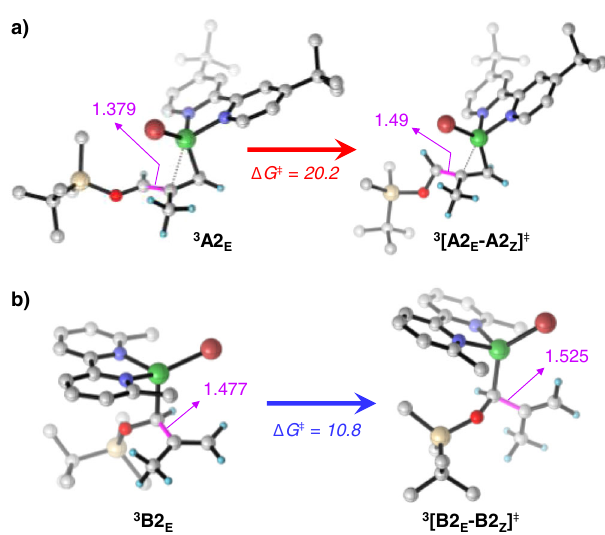
Fig. 8 | Transition states of isomerization step. For a ) ligand A (dtbbpy) and b ) ligand B (6,6'-dmpy), Rotation occurs around the C − C bond highlighted in pink.